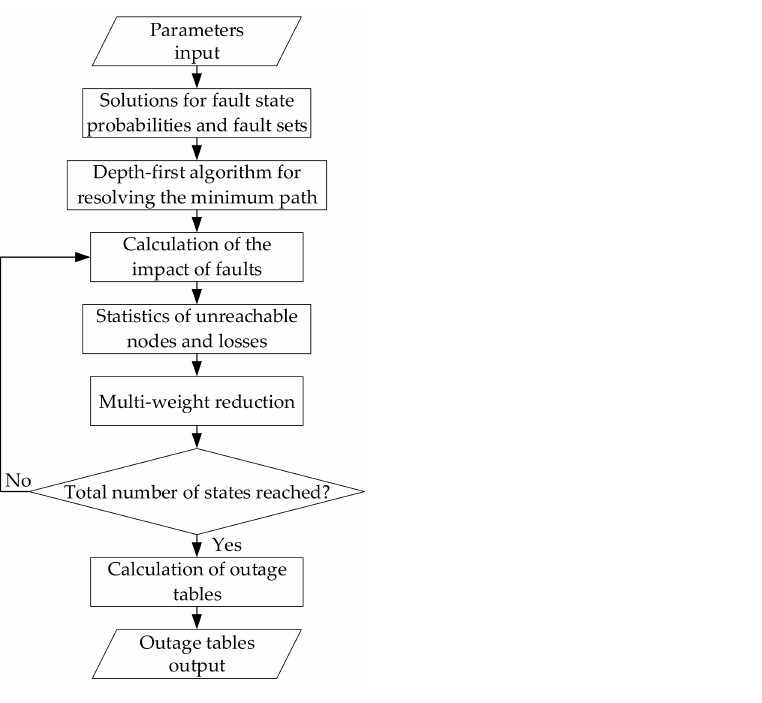
Figure 5. Flow chart for the distribution system outage table. Table 1. Overall power system reliability index